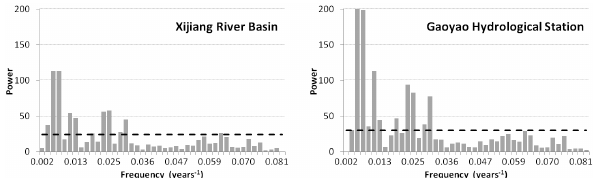
Fig. 9. Spectral analysis of the SPI-24 (left panel) and SDI-24 (right panel); the dashed line corresponds to the 90% confidence interval of significant